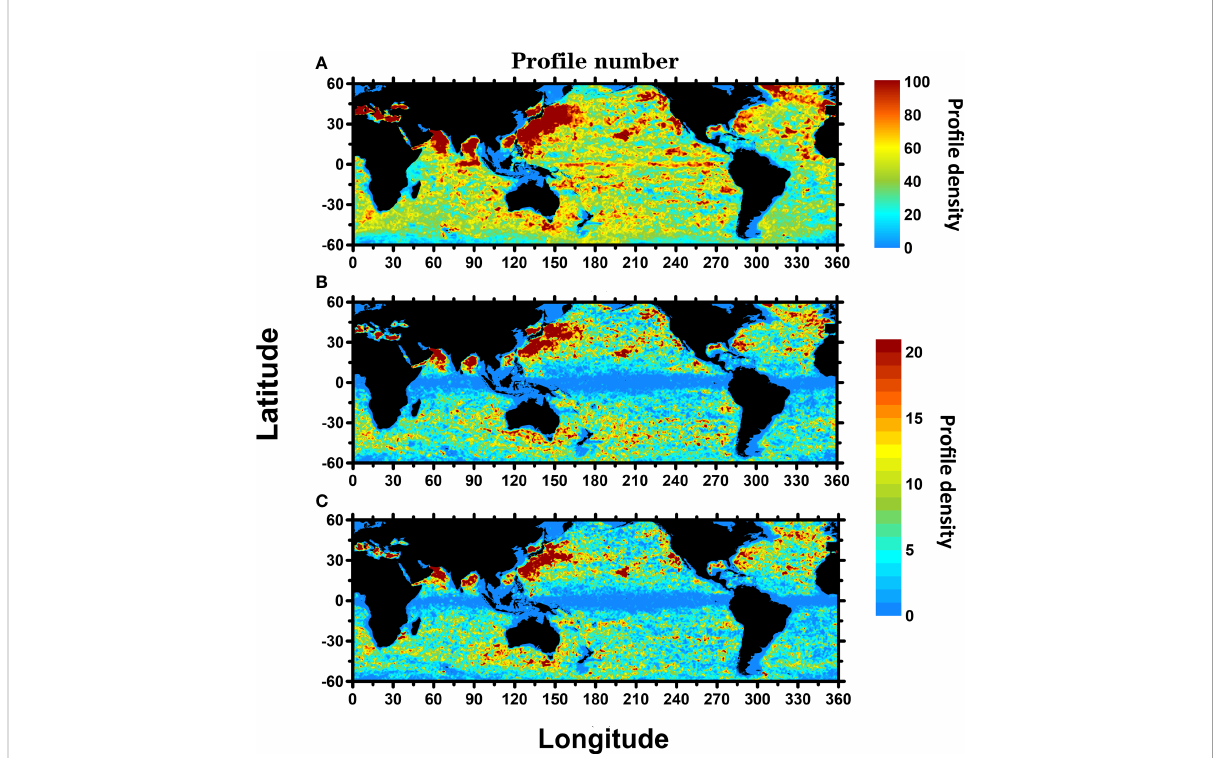
FIGURE 1 Global geographic distribution of Argo pro fi les during 2003 – 2017 under 1° × 1° grid. (A – C) Cumulative number of all pro fi les, pro fi les inside total matching anticyclonic eddies and total matching cyclonic eddies,